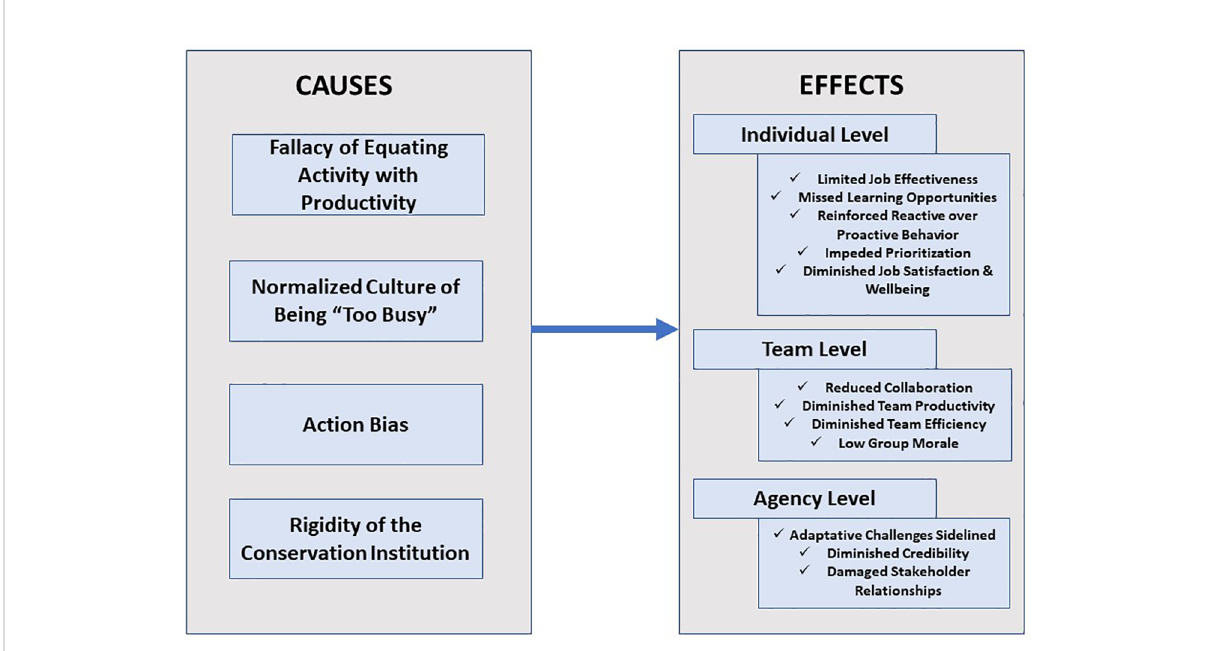
FIGURE 1 The Tyranny of Being Too Busy: Causes and Effects. Four broad causes of the “ too busy ” phenomenon in wildlife conservation and the associated impacts on individuals, work units or teams, and conservation